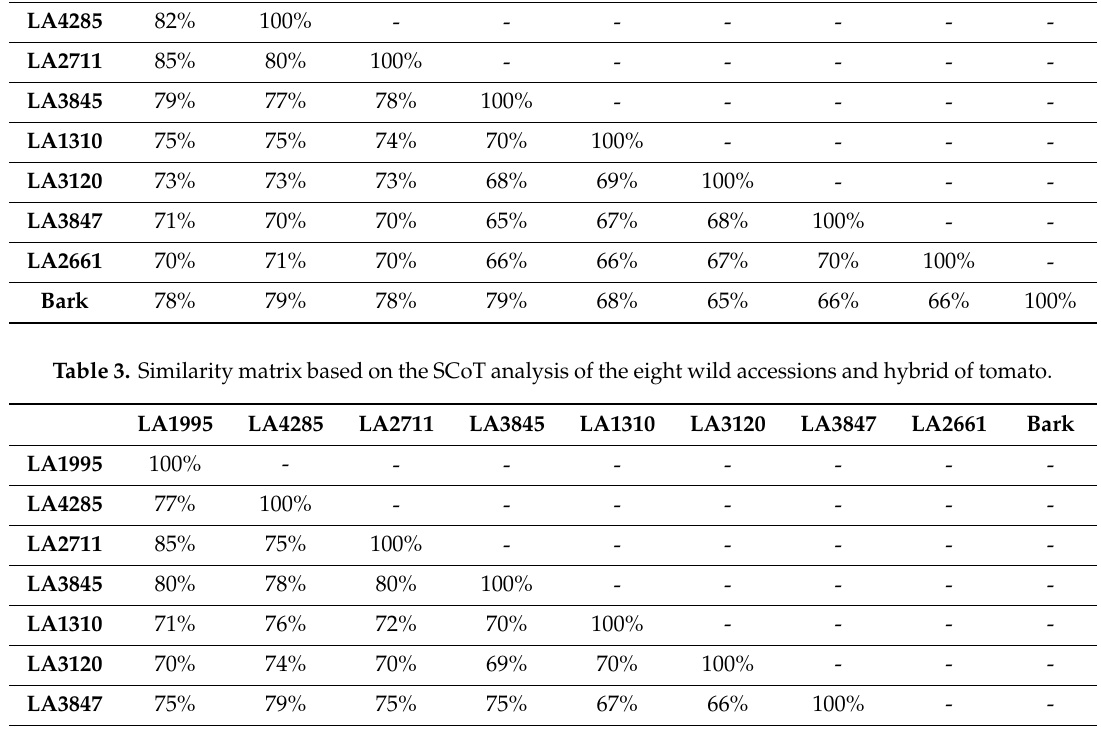
Table 2. Similarity matrix based on the CDDP analysis of the eight wild accessions and hybrid of tomato.